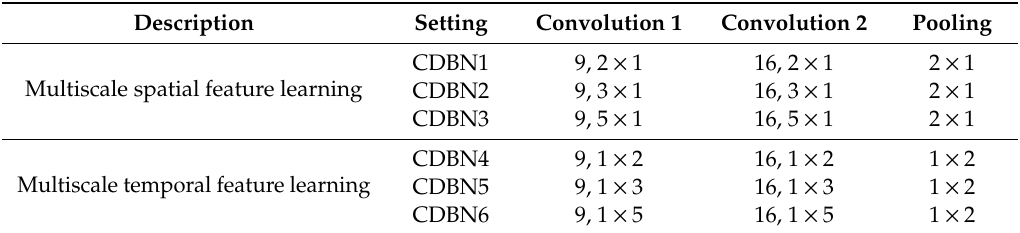
Table 4. The structure of the proposed